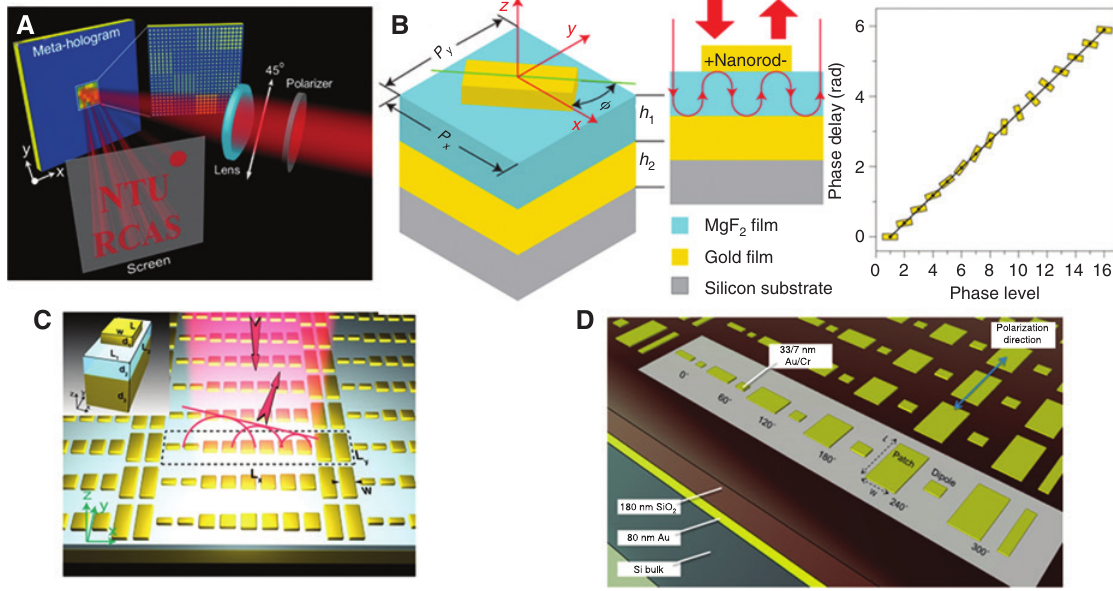
Figure 5: Plasmonic reflect-arrays. (A) Polarization control metasurface. Reprinted with permission from Ref. [24]. Copyright (2014) Ameri- can Chemical Society; (B) geometrical phase reflect-array. Reprinted by permission from Macmillan Publishers Ltd: Nature Nanotechnology [25], copyright (2014); (C) reflective deflector. Reprinted with permission from Ref. [33]. Copyright (2012) American Chemical Society; (D) broadband reflecive hologram. Reprinted with permission from Ref. [23]. Copyright (2014) American Chemical